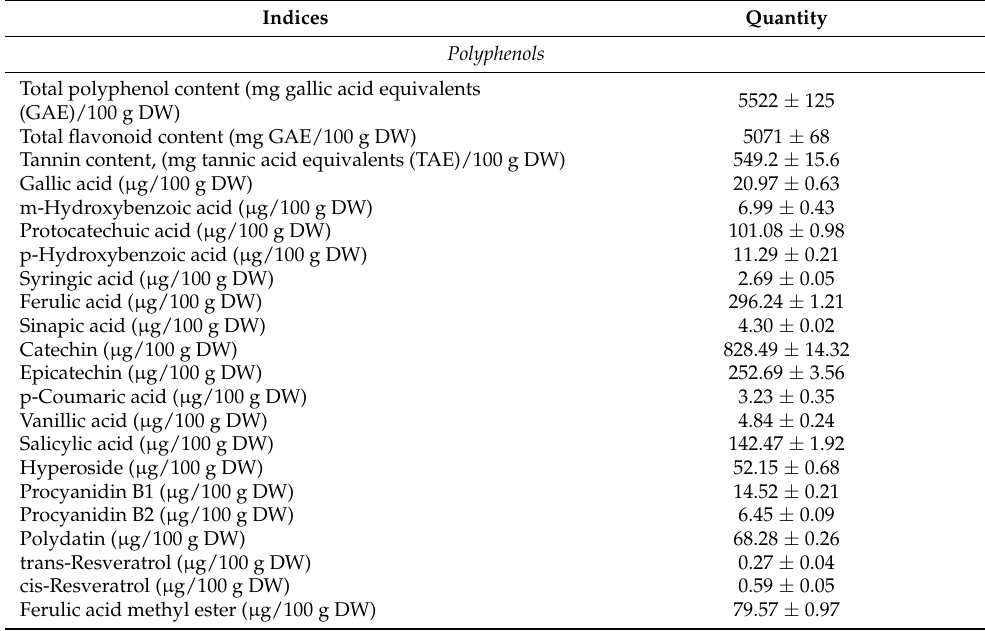
Table 3. Polyphenols, anthocyanins and individual organic acids, antioxidant activity and color parameters (CIELab) in aronia extract (the results are expressed as means ± standard deviations of three